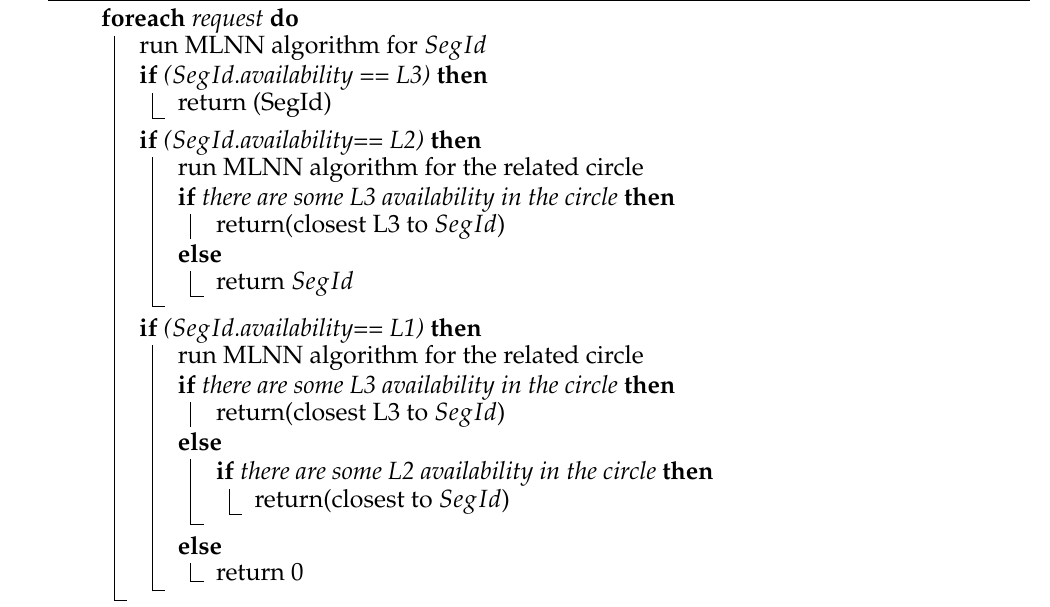
Algorithm 1: Segment-Selector ( SegId ,